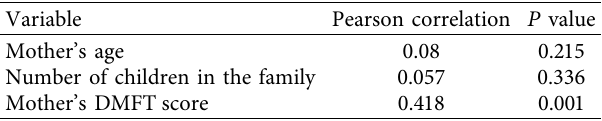
Table 2: Pearson correlation of different variables with dmft score of the children.